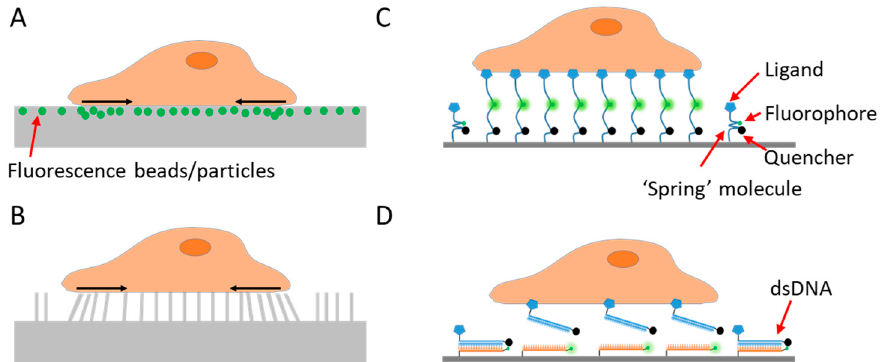
Figure 1. Schematics of techniques for cell adhesive force imaging. ( A ) Traction force microscopy (TFM) using an elastic polymer film doped with fluorescence beads or particles as the substrate. TFM converts cell adhesive force to substrate deformation. ( B ) TFM using micropillar arrays as the substrate. TFM records the bending of the micropillar arrays and computes the cell adhesive force. ( C ) Fluorescent tension sensor (FTS) converts cell adhesive force to fluorescence using an “entropic spring” molecule. ( D ) FTS based on binary material with distinct on/off states such as double-stranded DNA (dsDNA) or hairpin DNA.